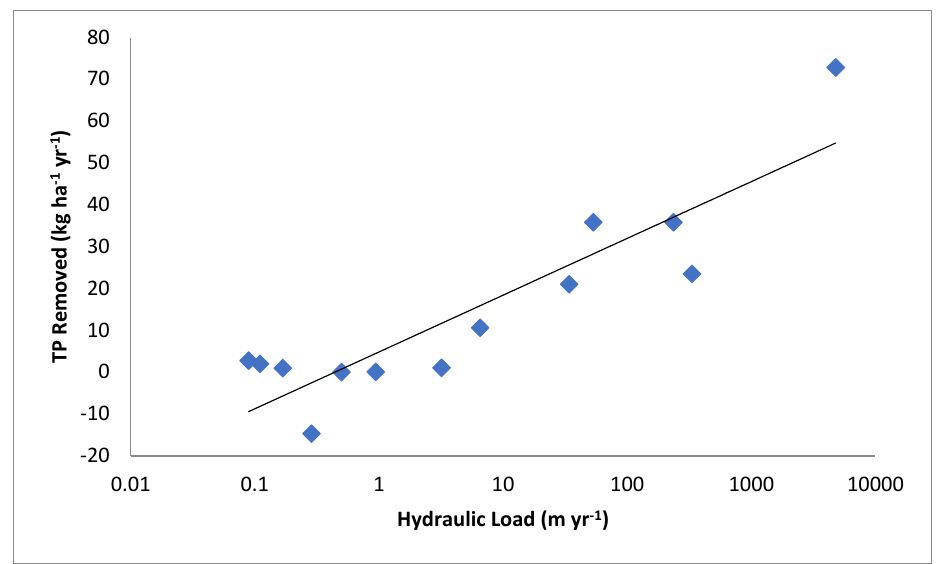
Figure 5. Relationship between the hydraulic load entering each floodplain and total phosphorus (TP) mass removed (y = 5.8913ln(x) + 4.8823, ρ = 0.75, p = 0.003).